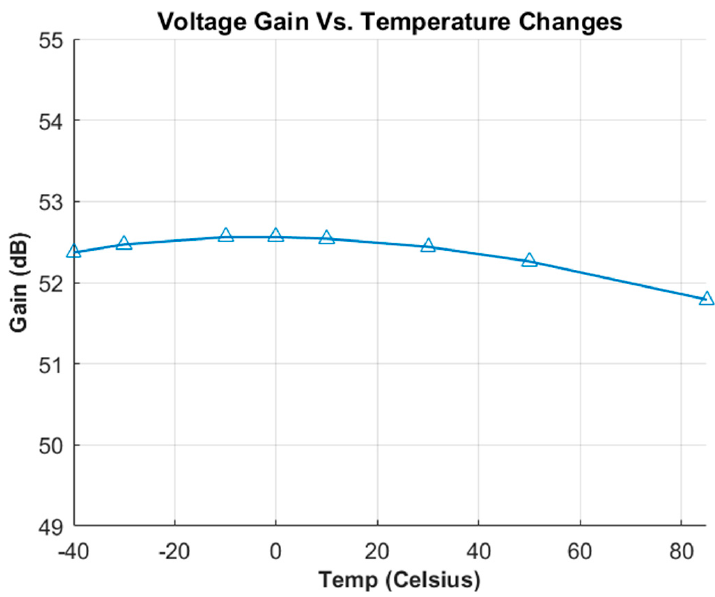
Figure 11. The proposed ampli fi er’s voltage gain changes due to di ff erent temperatures.